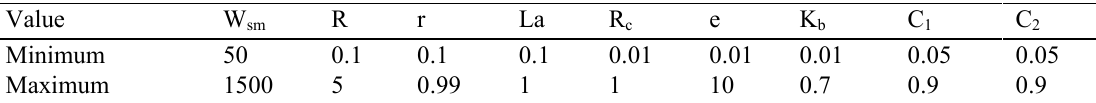
Table 2 The range of HIMS model parameters.